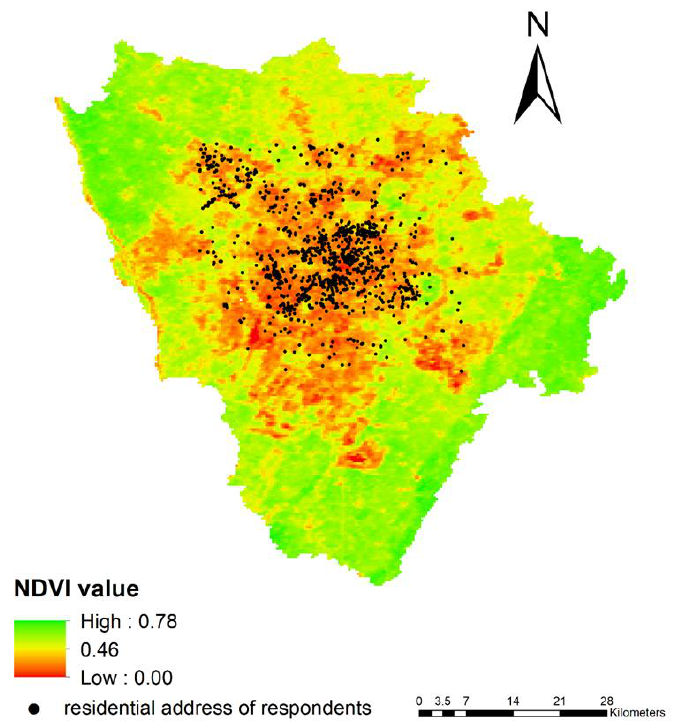
Figure 2. The NDVI value and secondhand smoke (SHS) exposure at home among non-smoking migrant workers. NDVI: Normalized Difference Vegetation Index.